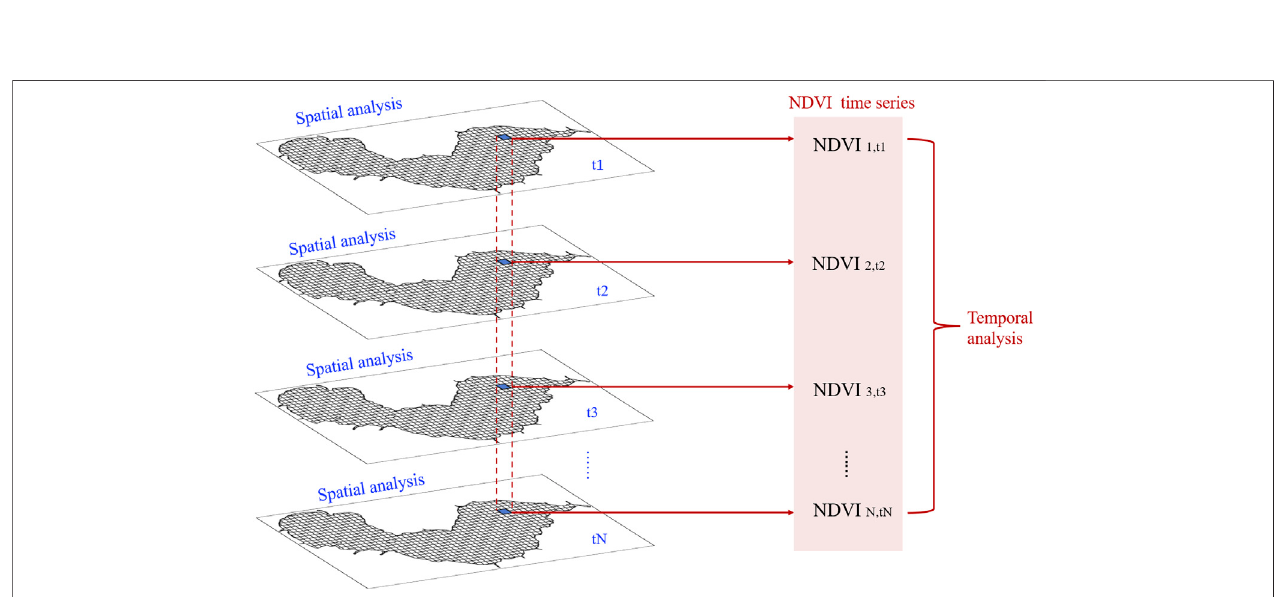
FIGURE 3 | Illustration of spatial and temporal analysis based on grid